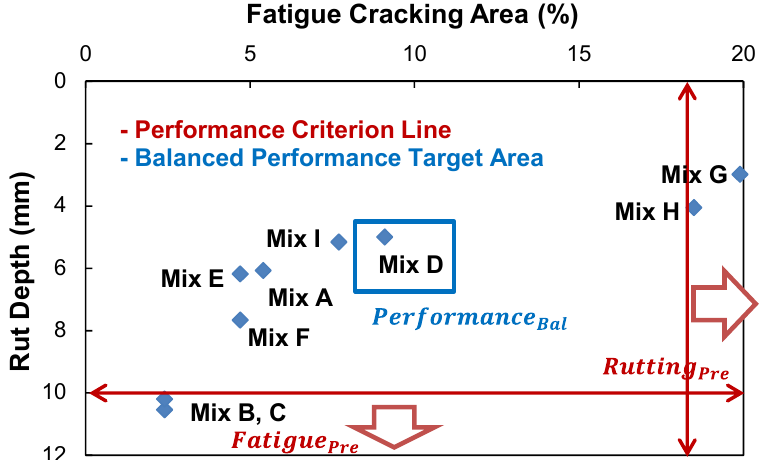
Figure 18. Selected PBMD mix designs based on performance levels for structural simulations.